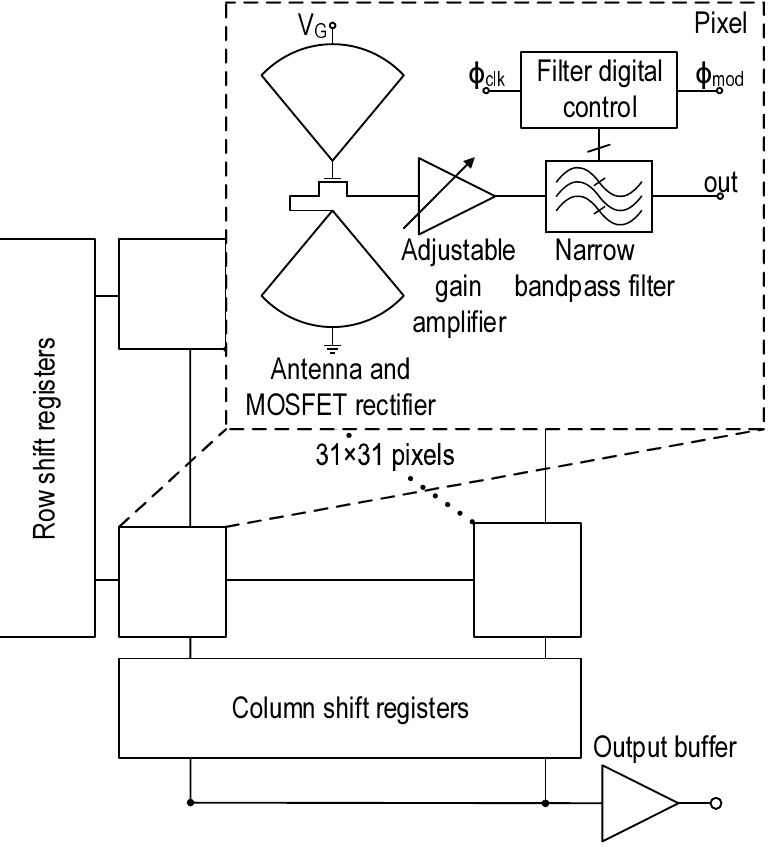
Figure 3. Overall block diagram of the CMOS THz